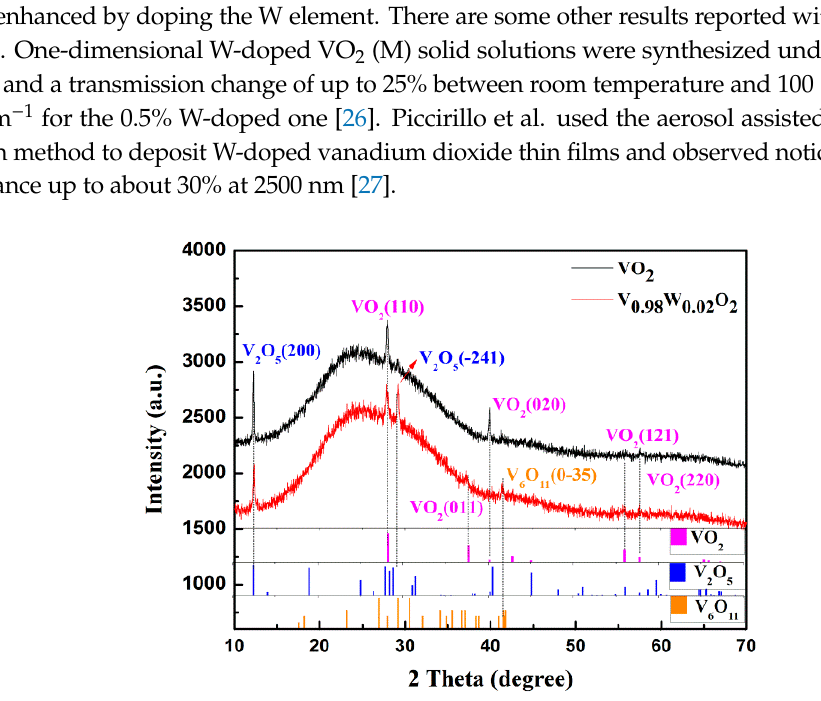
Figure 3. XRD curves of pure and W-doped VO 2 films fabricated on amorphous K9 glass substrates. The films were sputtered with the power of 500 W: 0 W and 0 W: 500 W for the pure and 2% W-doped V targets without heating, respectively. They were annealed at 530 ◦ C for 30 min with oxygen pressure of 18 Pa.